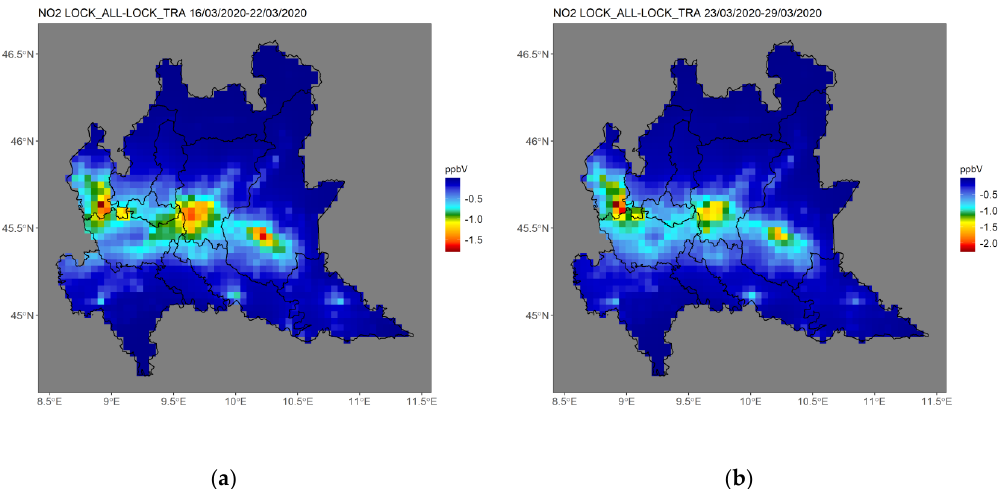
Figure 8. Absolute difference in NO 2 concentration between LOCK_ALL and LOCK_TRA for week 4 ( a ) and week 5 ( b ). Figures 9 and 10 show NO 2 time series measured and simulated with CAMx model, respectively for the city of Milan and for the cities of Bergamo and Brescia, during the case study period. As introduced in Section 2.1, during the analyzed period, unstable and stable atmospheric conditions succeeded one another, leading to, respectively, dispersion and accumulation of the NO 2 atmospheric concentration. The role of primary nitrogen dioxide [57] emissions in the development of NO 2 concentrations in a traffic environment explains the immediate response of the NO 2 atmospheric concentration once the measures adopted to face the COVID-19 pandemic started. This trend can be appreciated in both the modeled and measured time series. The reduction in pollutant concentration was enhanced by the foehn event at the end of February. Another example of the impact of meteorological conditions on NO 2 concentration is the increase in temperature and low